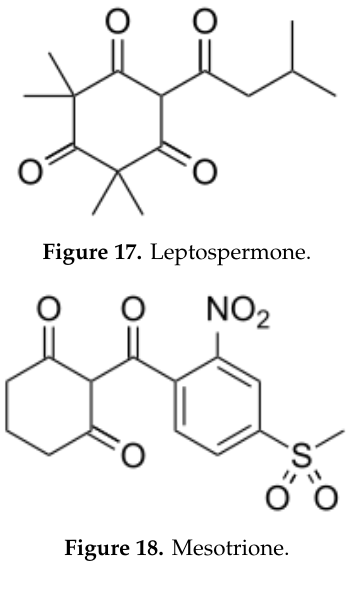
Figure 18. Mesotrione.